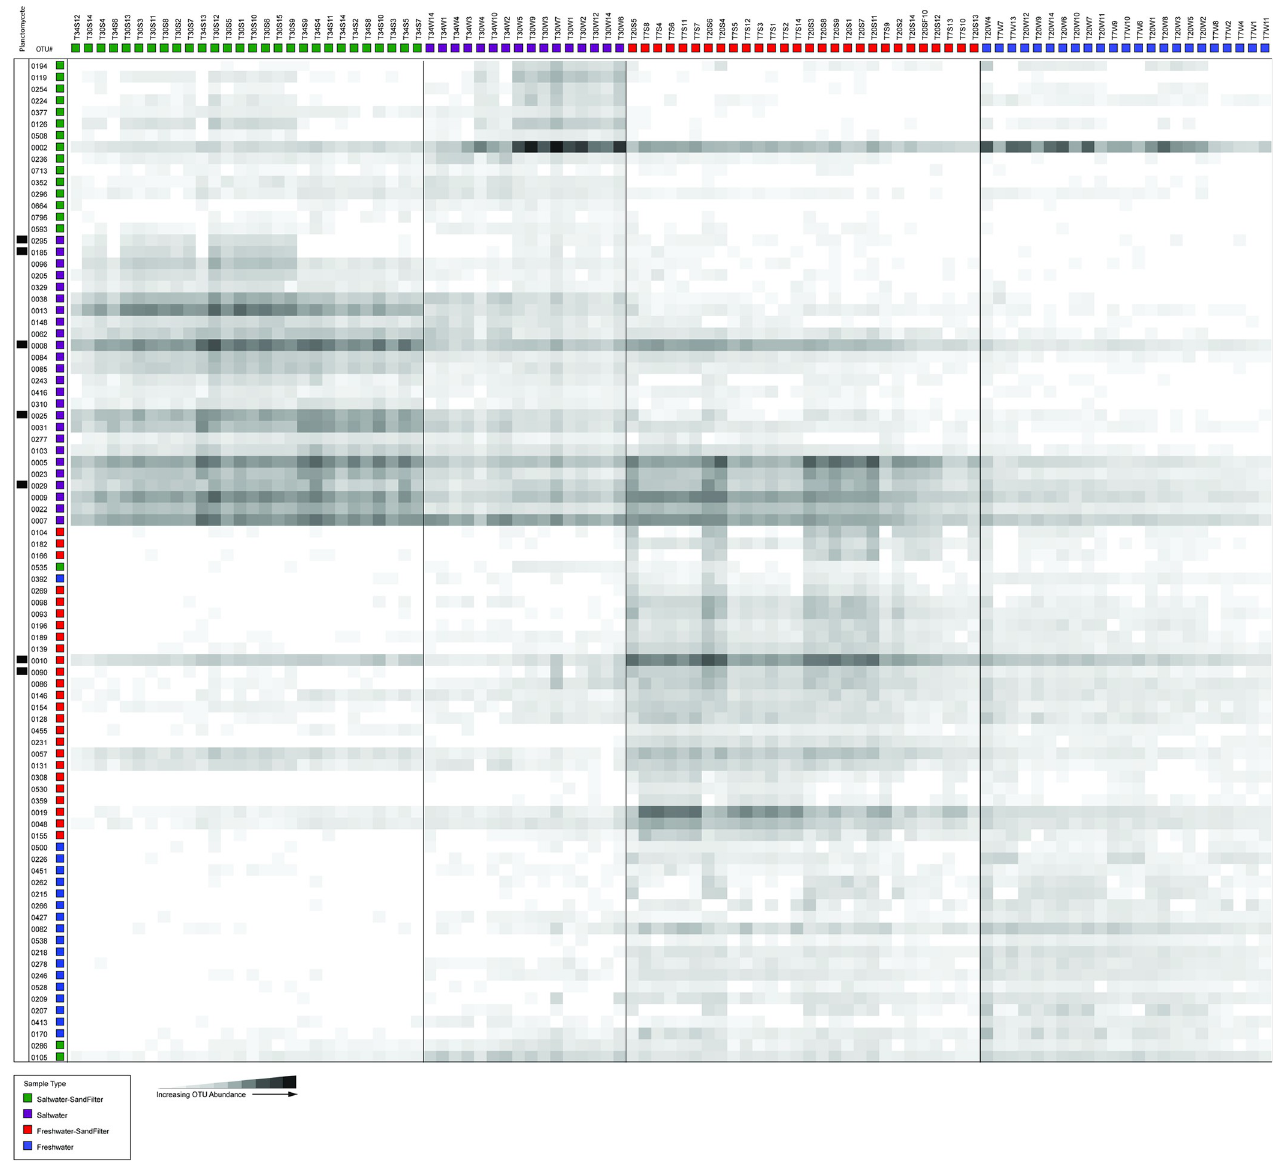
Fig 4. Heatmap displaying the abundance of biomarker OTUs identified from each habitat. Planctomycete OTUs are indicated by black bars left of OTU numbers. See S5 Table for taxonomic identification of OTUs.